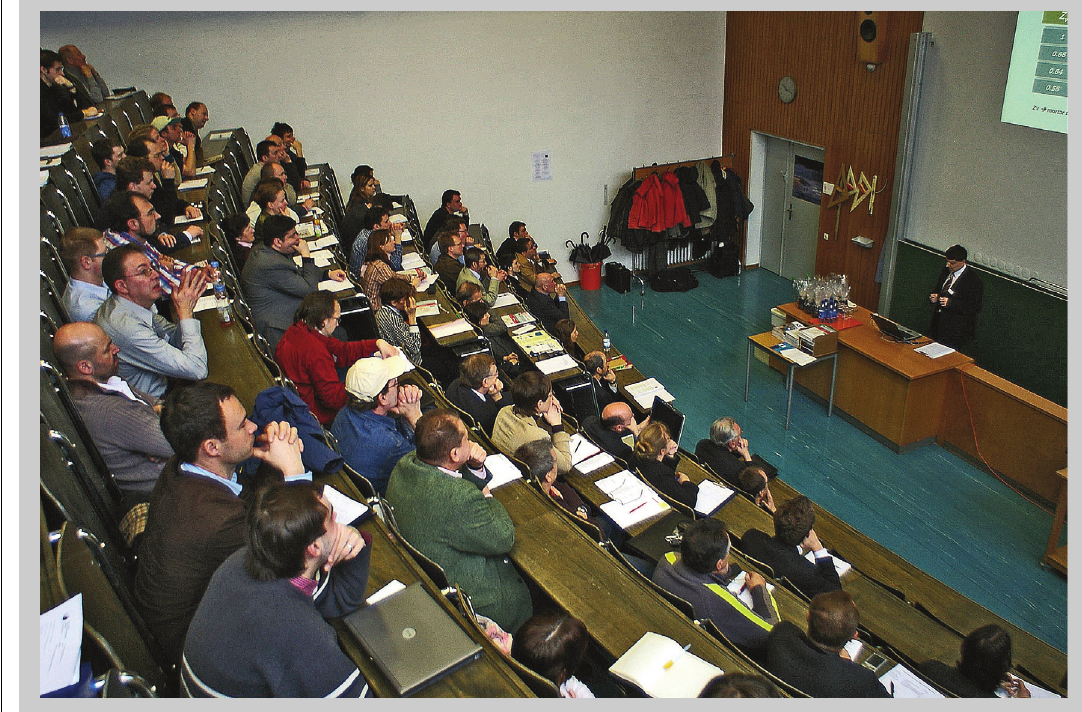
Figure 1: Participants of “Rheology of Building Materials 2008” in